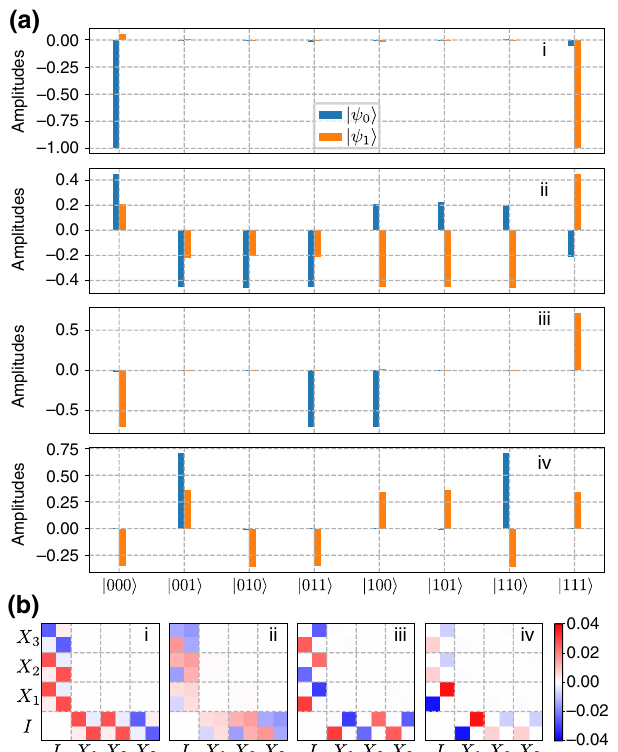
FIG. 7. (a) Discovered three qubit bit-flip codes from four dif- ferent runs. (b) QEC matrix for each of the discovered encoding, representing deviations from the perfect QEC criteria.